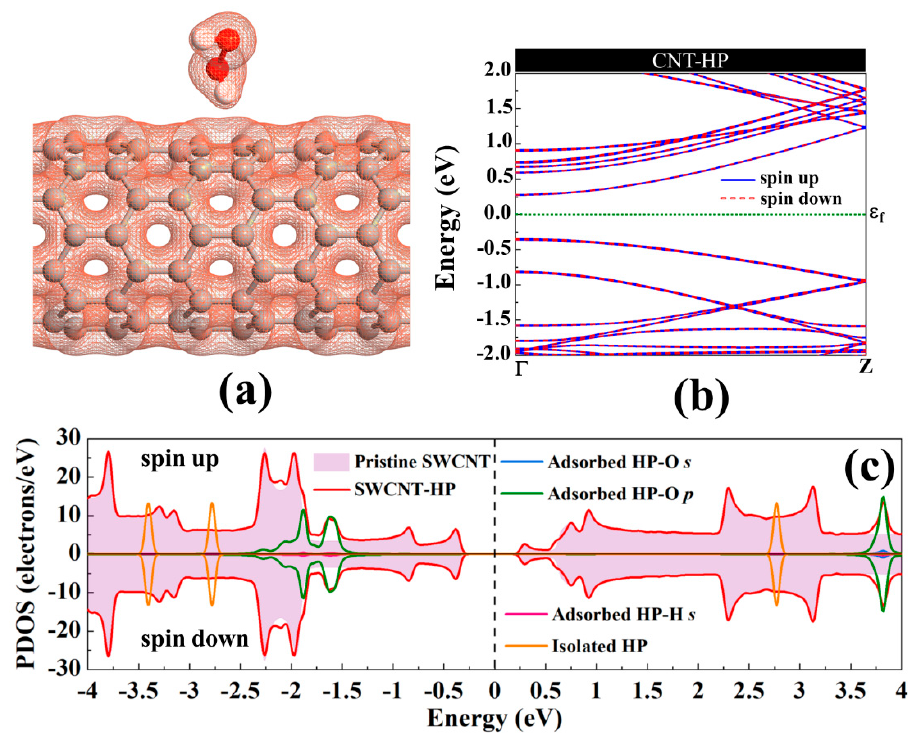
Figure 3. ( a ) The electronic total charge density, ( b ) energy band structure, and ( c ) total DOS curve for H 2 O 2 adsorption on pristine (8,0) SWCNT. The Fermi level is set to zero.